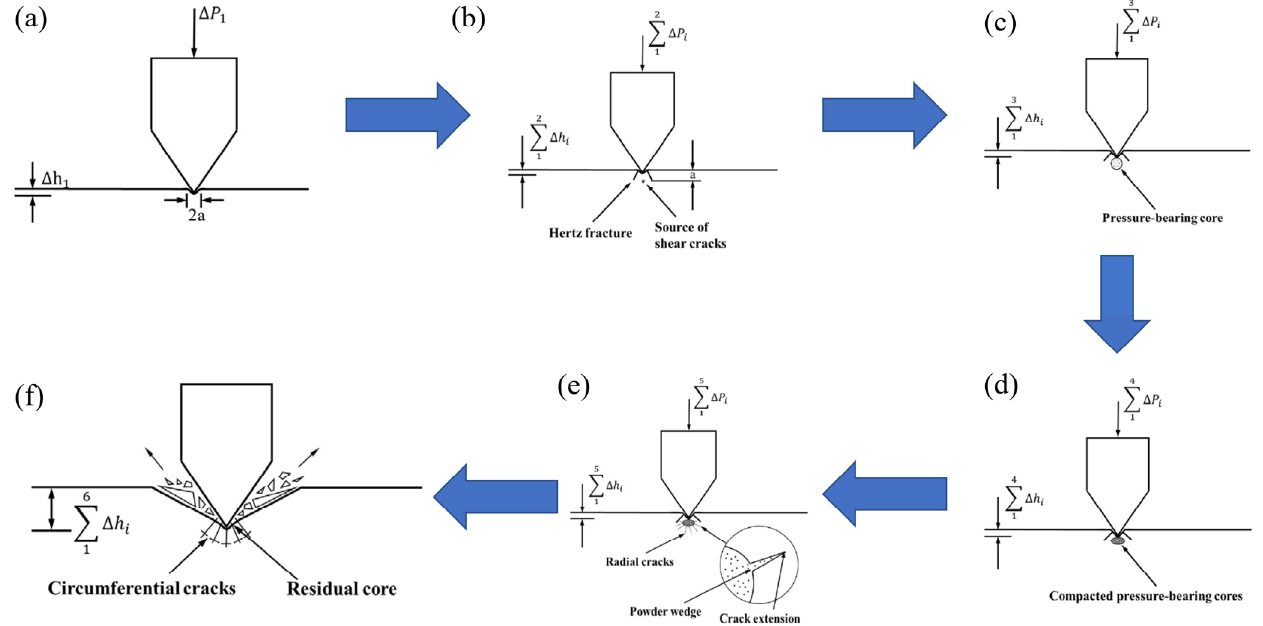
Figure 9. Model of the intrusion damage mechanism (after Yu [26]): ( a ) deformation stage ( b ) crack source emergence stage ( c ) pressure-bearing core emergence stage ( d ) pressure-bearing core energy storage stage ( e ) radial cracking and powder splitting stage ( f ) unloading stage.